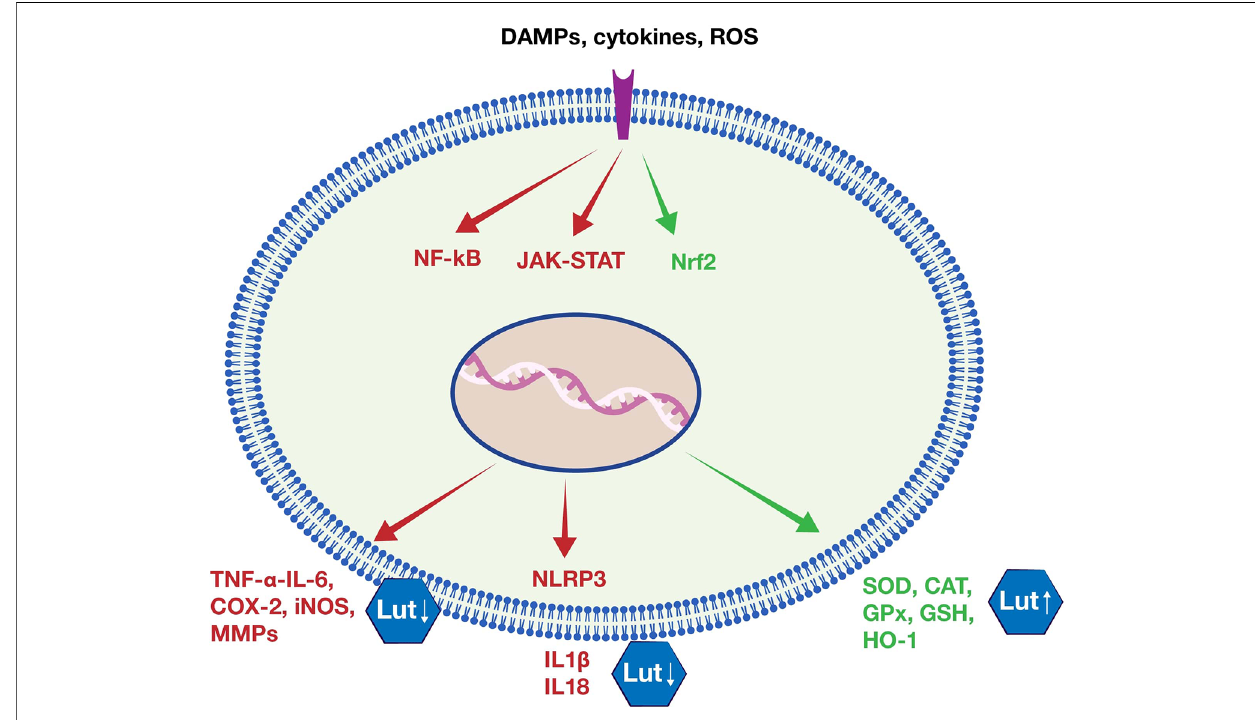
FIGURE 5 Luteolin ’ s anti-in fl ammatory and antioxidant effects. Luteolin inhibits major in fl ammatory signaling pathways (e.g., NF- κΒ , JAK-STAT, NLRP3), leading consequently to reduced expression of pro-in fl ammatory mediators (e.g., TNF- α , IL-6, COX-2, iNOS, MMPs, IL1 β , IL18). Moreover, luteolin seems able to activate the major antioxidant factor Nrf2, and increase the expression of antioxidant enzymes (e.g., SOD, CAT, GPx, GSH,